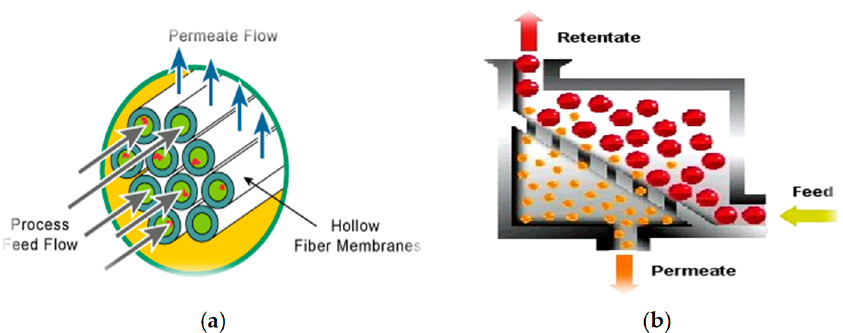
Figure 1. Hollow fibers VPU-15PA.